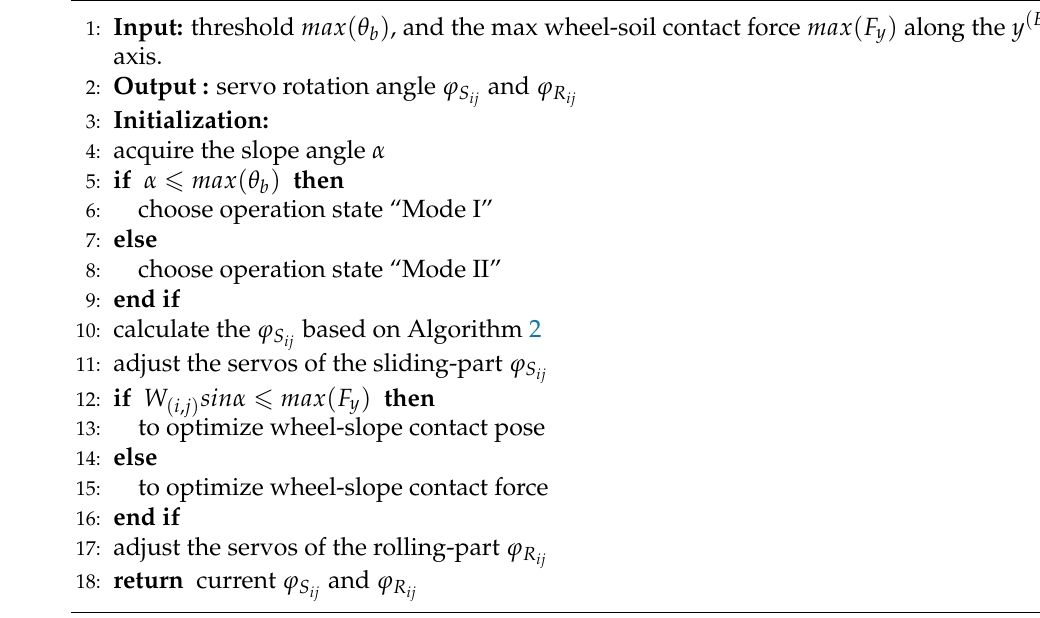
Algorithm 1 Attitude control strategy for slope traversing.